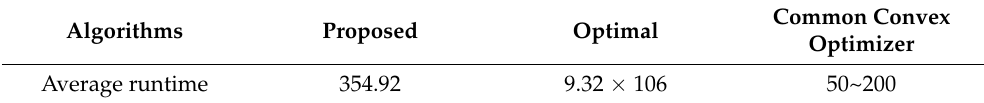
Table 5. Comparison of runtime